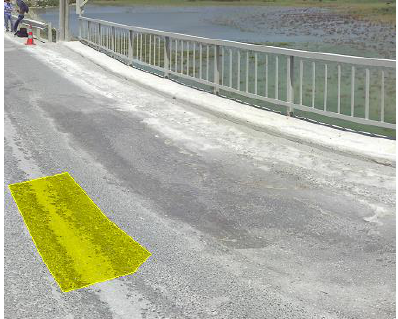
Figure 3: The selected region on the bridge deck for surface damage detection.